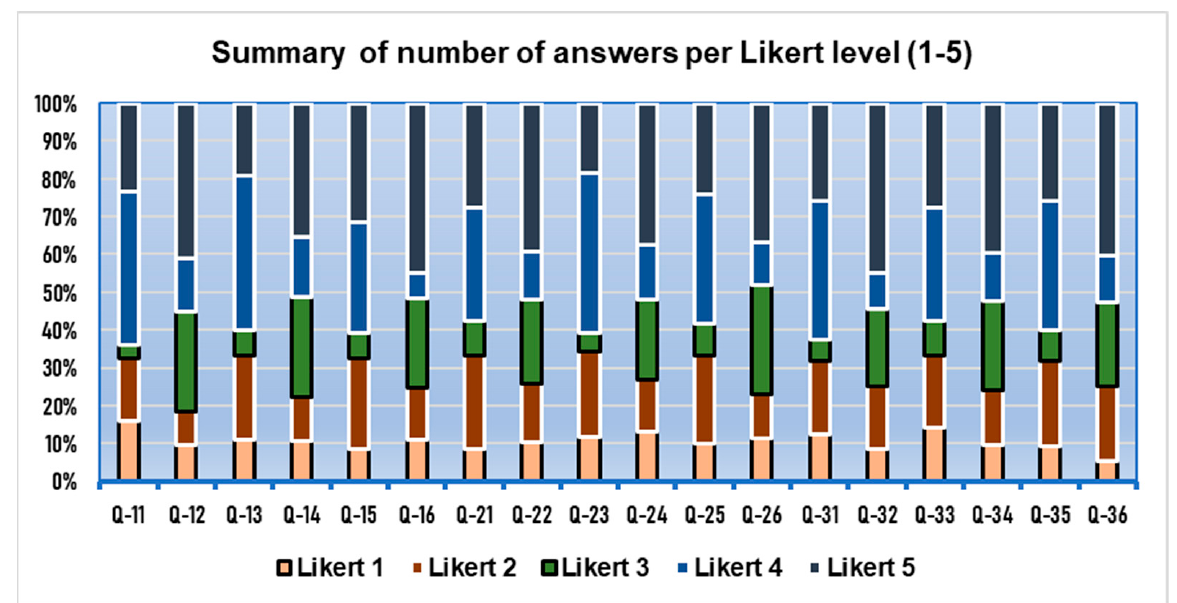
Figure 1. Polytomous responses for a database with negative asymmetry and well-paired data (Fic L—Rel).